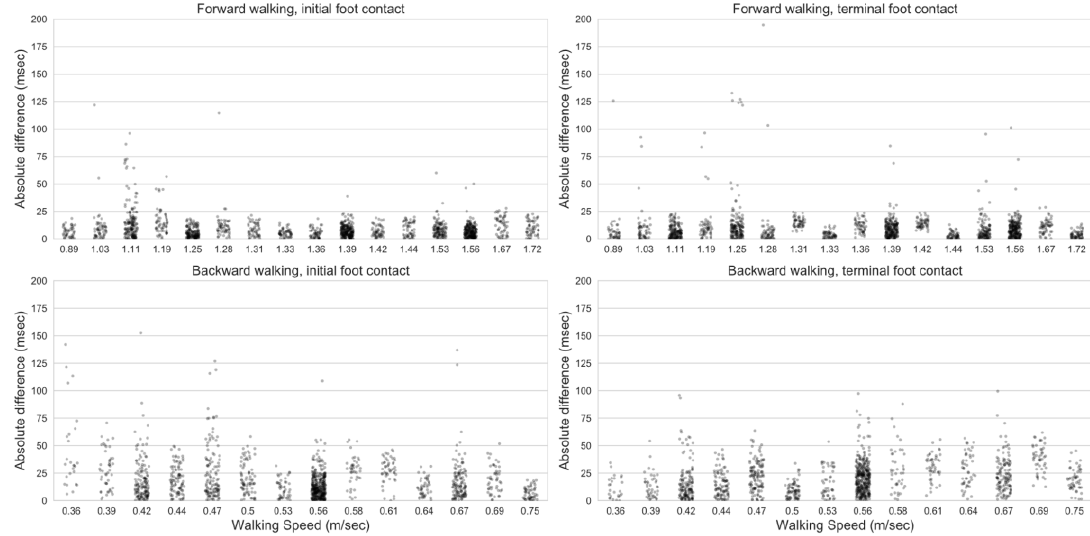
Figure 5. Absolute difference vs. walking speed.